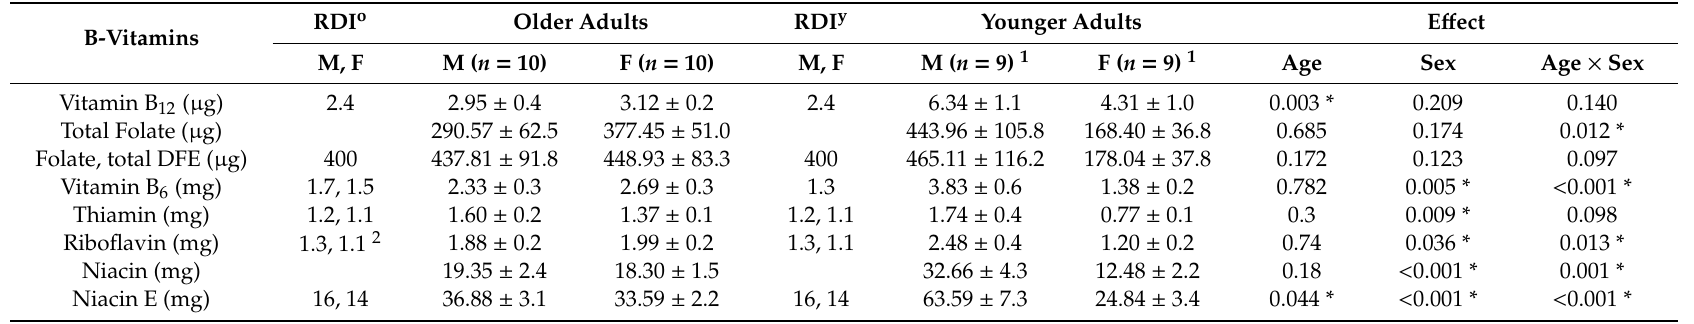
Table 4. Estimated habitual B-vitamin intake of the study participants from 3-day dietary intake